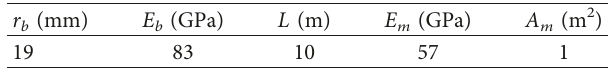
Figure 7: Comparison between the experimental result acquired from Bai et al. [58] and the analytical result. Table 3: Mechanical properties of the cable bolt and the confining medium used in this